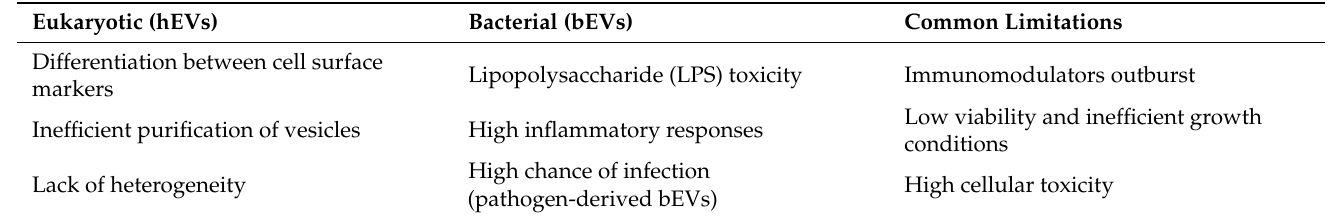
Table 2. Current limitations of eukaryotic and bacterial EVs in biomedical applications. Eukaryotic (hEVs) Bacterial (bEVs) Common Limitations Differentiation between cell surface